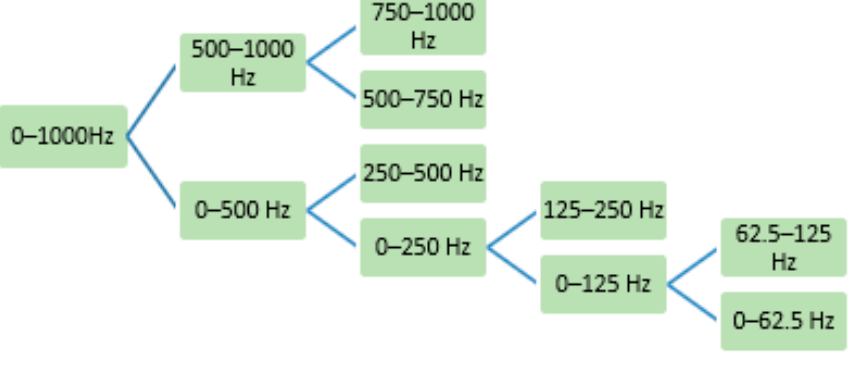
Figure 4. Flowchart of 4 levels of DWPT.